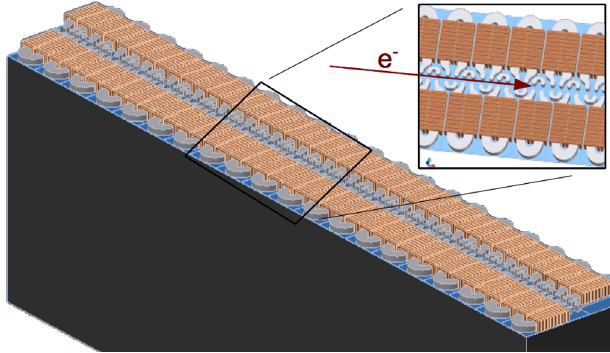
FIG. 1. CAD rendering of a potential microundulator design on a 500 (cid:1) m thick silicon